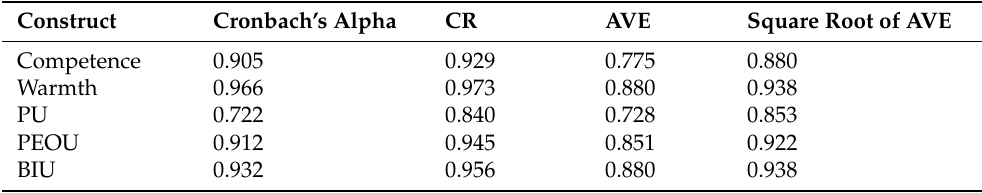
Table 2. Cronbach’s alpha, CR, AVE, and square root of AVE.